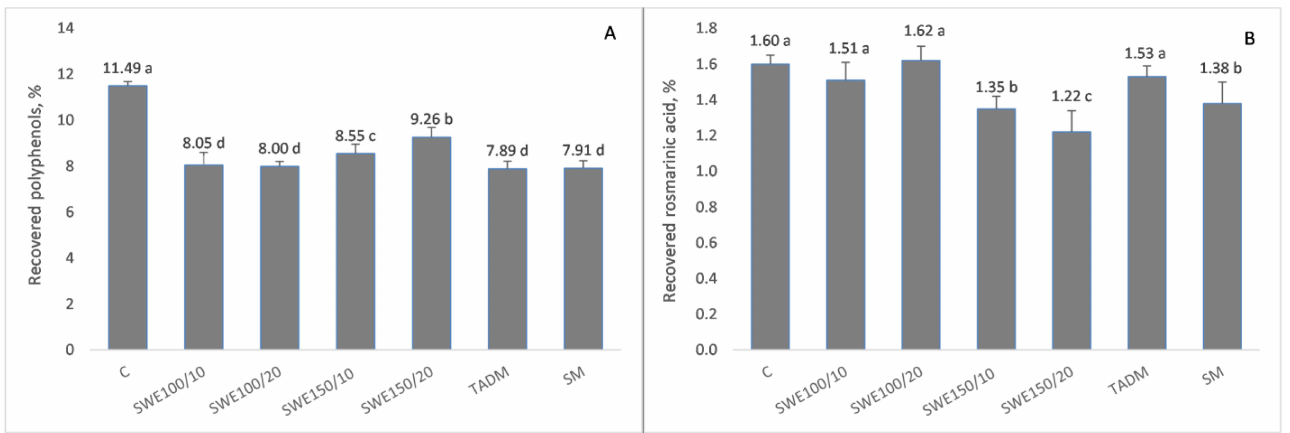
Figure 1. Effect of extraction method on the recovery of total polyphenols (panel ( A )) and rosmarinic acid (panel ( B )) from lemon balm leaves. Results are presented as mean values ± SD. There are no significant differences among values marked with the same letters (a, b, c, d) within individual